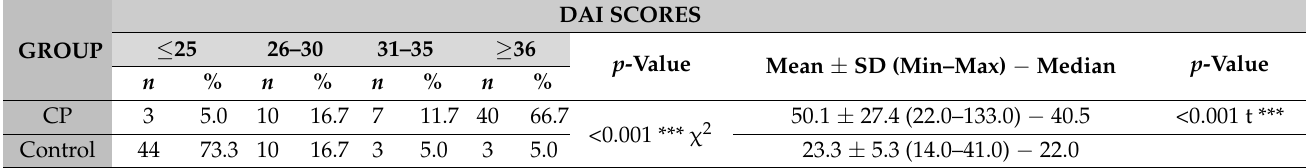
Table 4. Descriptive scores of the Dental Aesthetic Index (DAI) components and bivariate analysis between the DAI score and the two groups: Cerebral Palsy (CP) and Control Group. X 2 : chi-squared test; t: Student’s t -test; p < 0.001